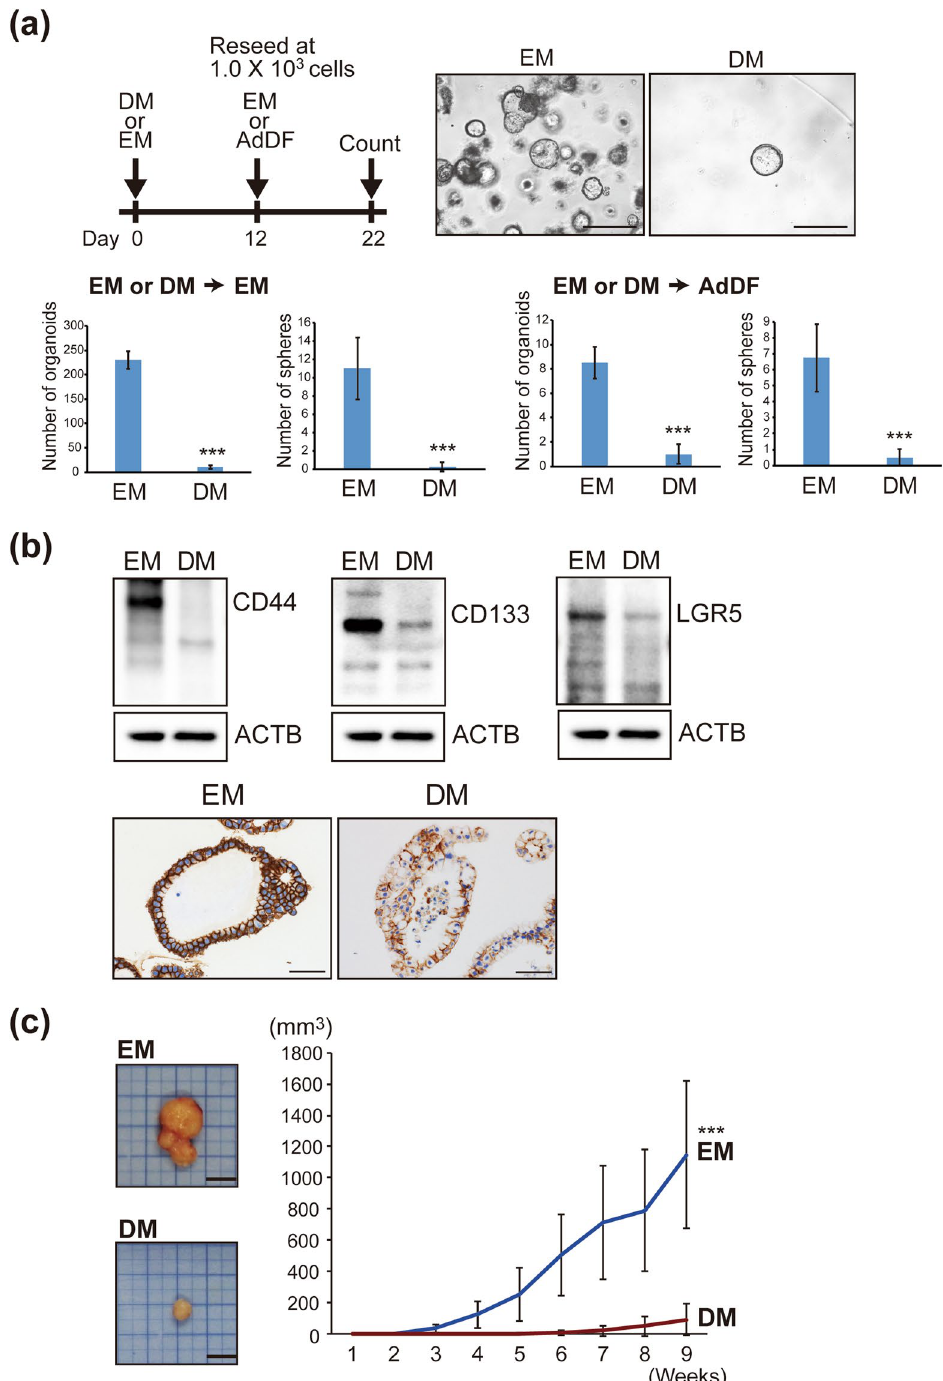
Figure 4. Hepatocyte differentiation reduces the malignant potential of IHCC cells in vitro and in vivo . ( a ) Schedule for hepatocyte differentiation and counting of organoids and spheres. IHCC organoids were cultured in DM or EM for 12 days, then reseeded at 1.0 × 10 3 cells and cultured in EM or Advanced DMEM/F12 (AdDF) with 10% FBS for 10 days. The numbers of organoids and spheres were counted. Scale bars: 500 μ l. ( b ) Western blotting of the tumor initiating markers CD44, CD133 and LGR5 in IHCC organoids cultured in EM or DM (upper). Immunohistochemical staining of CD44 in IHCC organoids cultured in EM or DM (lower). Scale bars: 50 μ m. ( c ) Tumor volumes of xenografted IHCC organoids cultured in EM or DM. We implanted 1 × 10 6 cells of IHCC organoids cultured in EM or DM subcutaneously into the backs of SCID mice. Tumor volumes of xenografted IHCC organoids cultured in EM (n = 8) or DM (n = 8) on SCID mice were